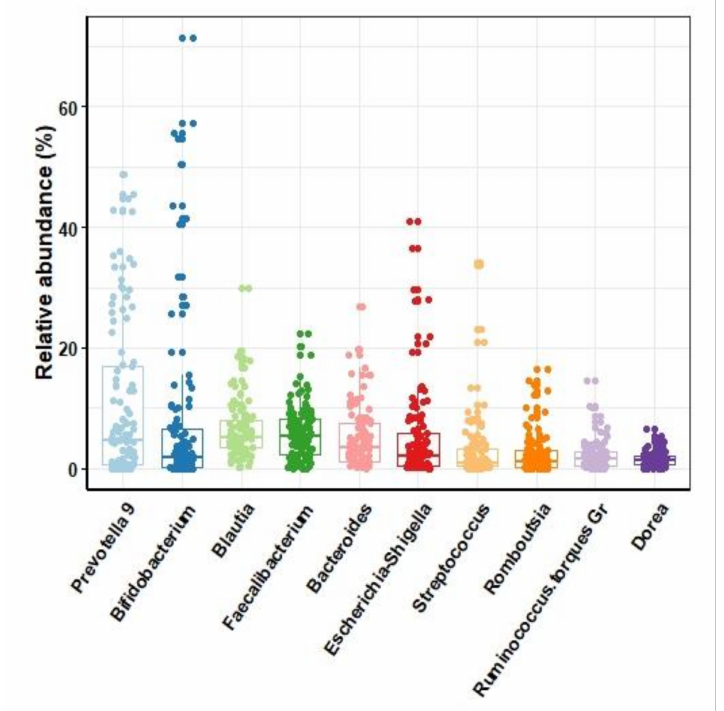
Figure 1. Relative abundance of the most predominant genera in human feces samples. Boxes show the median and interquartile ranges, while whiskers show the 95%